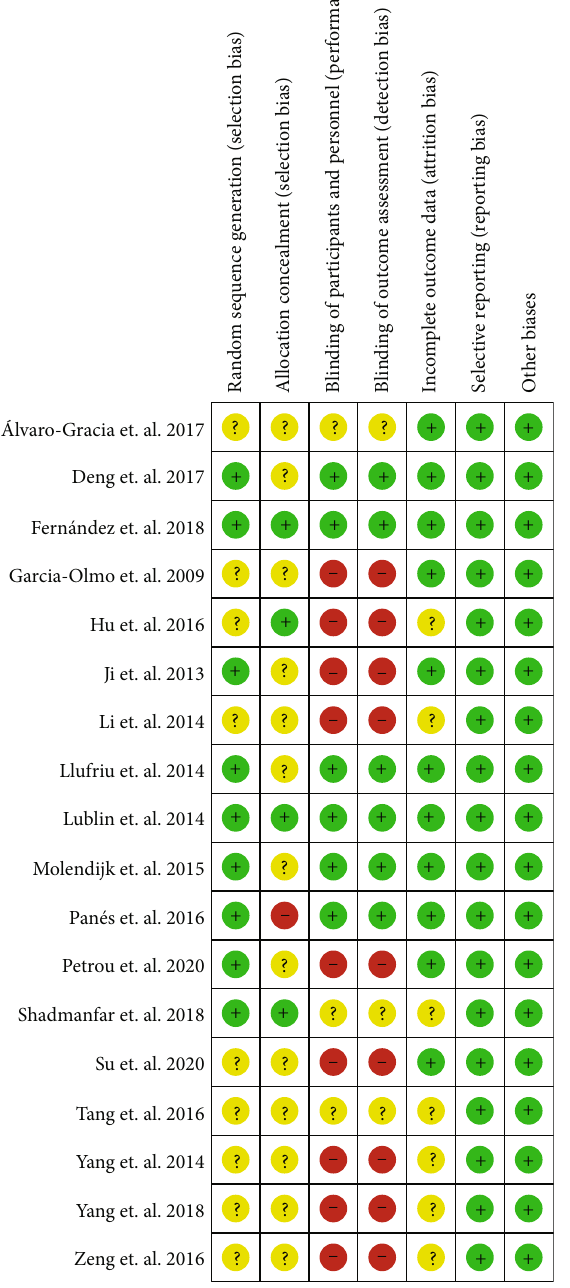
Figure 3: Risk of bias